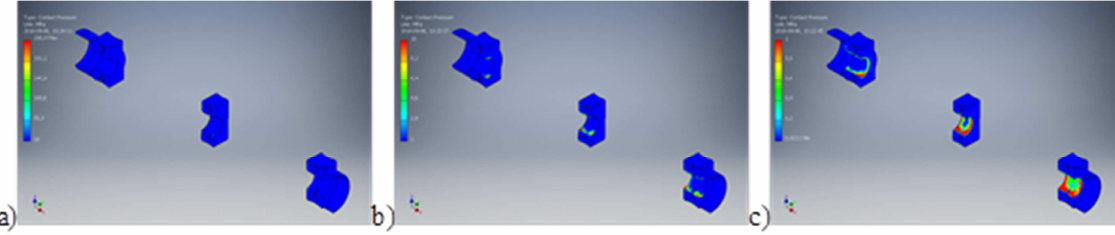
Fig. 17. The distribution of contact pressure on surfaces of the bearing covers for the rotational speed of the camshaft equal to 2000